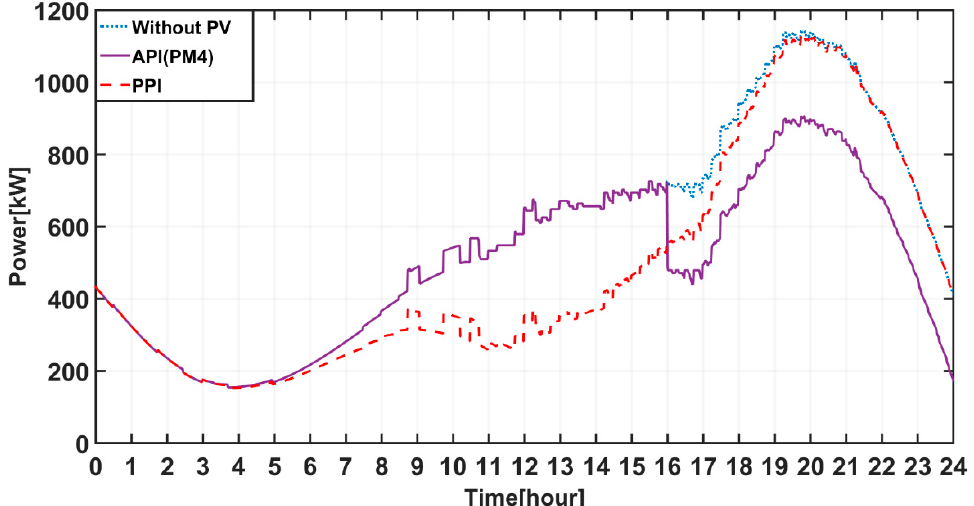
Figure 9. DT loading with different PV integration approaches (EV penetration ratio: 20%).